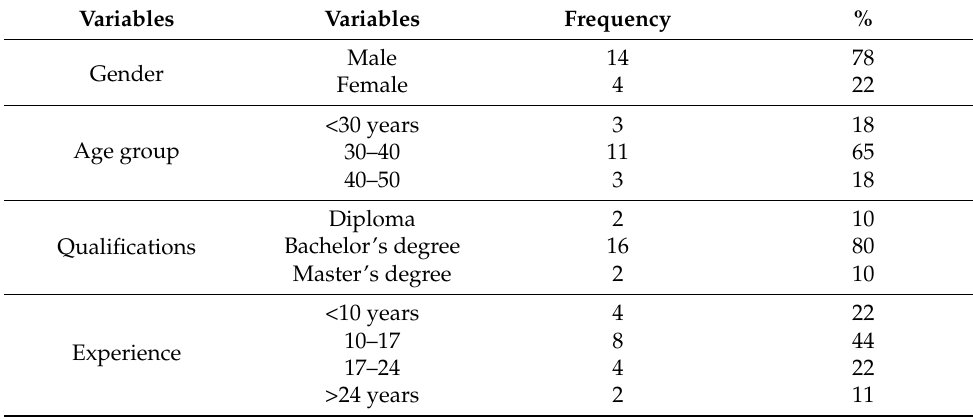
Table 2. Distribution of RTs’ demographics by characteristics variables in